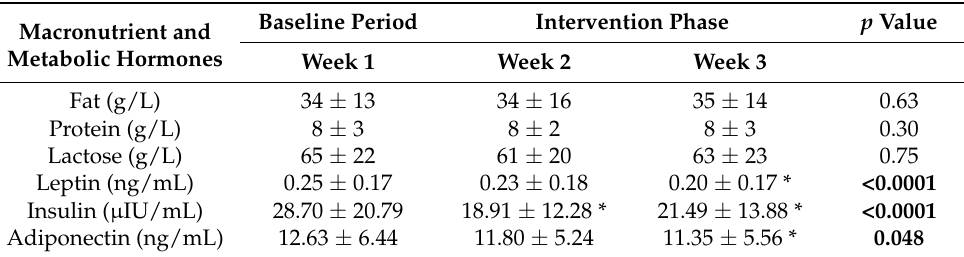
Table 4. Overview of human milk macronutrient and metabolic hormone concentrations before and after dietary intervention 1